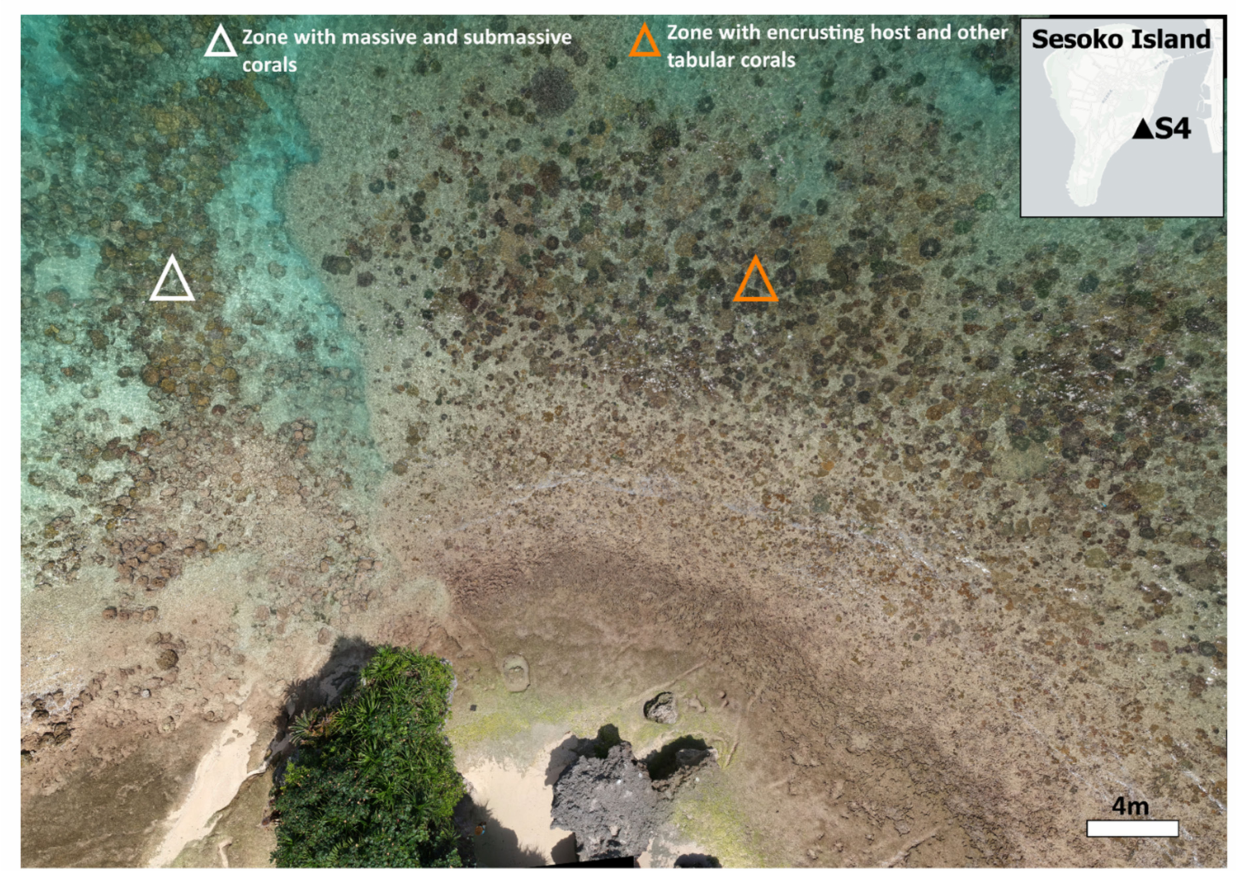
Figure 2. Aerial imagery to highlight the distribution of the host encrusting Montipora and other forms of corals including massive and submassive Porites and tabular Acropora . Aerial photograph: Hideyuki Yamashiro. For information on site S6 and S11 refer to